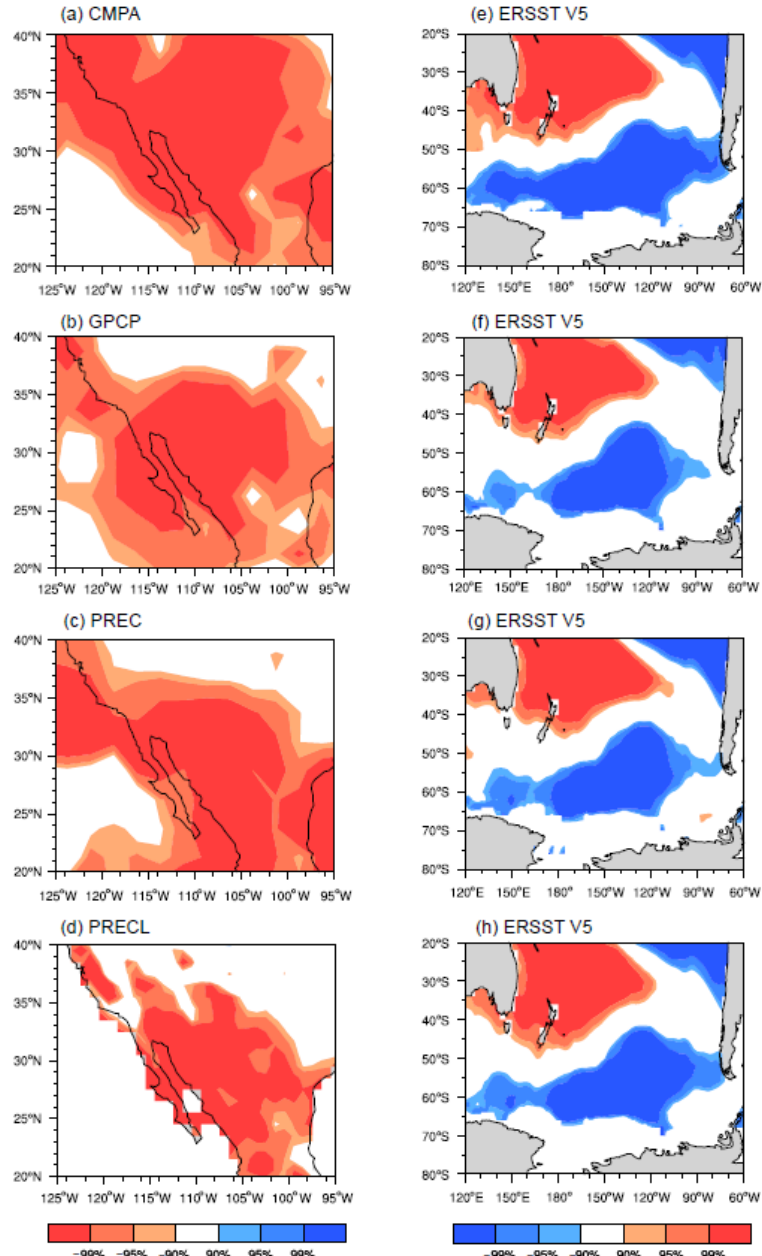
Figure 1. Heterogeneous correlation maps of the leading singular value decomposition (SVD) mode for winter precipitation in the North American monsoon (NAM) region calculated using the ( a ) CPC Merged Analysis of Precipitation (CMAP), ( b ) GPCP, ( c ) Precipitation Reconstruction (PREC), and ( d ) Precipitation Reconstruction over Land (PRECL) datasets, and ( e – h ) autumn sea surface temperature (SST) in the South Pacific Ocean based on the ERSST V5 datasets. The shading indicates significance at the 90%, 95%, and 99% confidence levels.